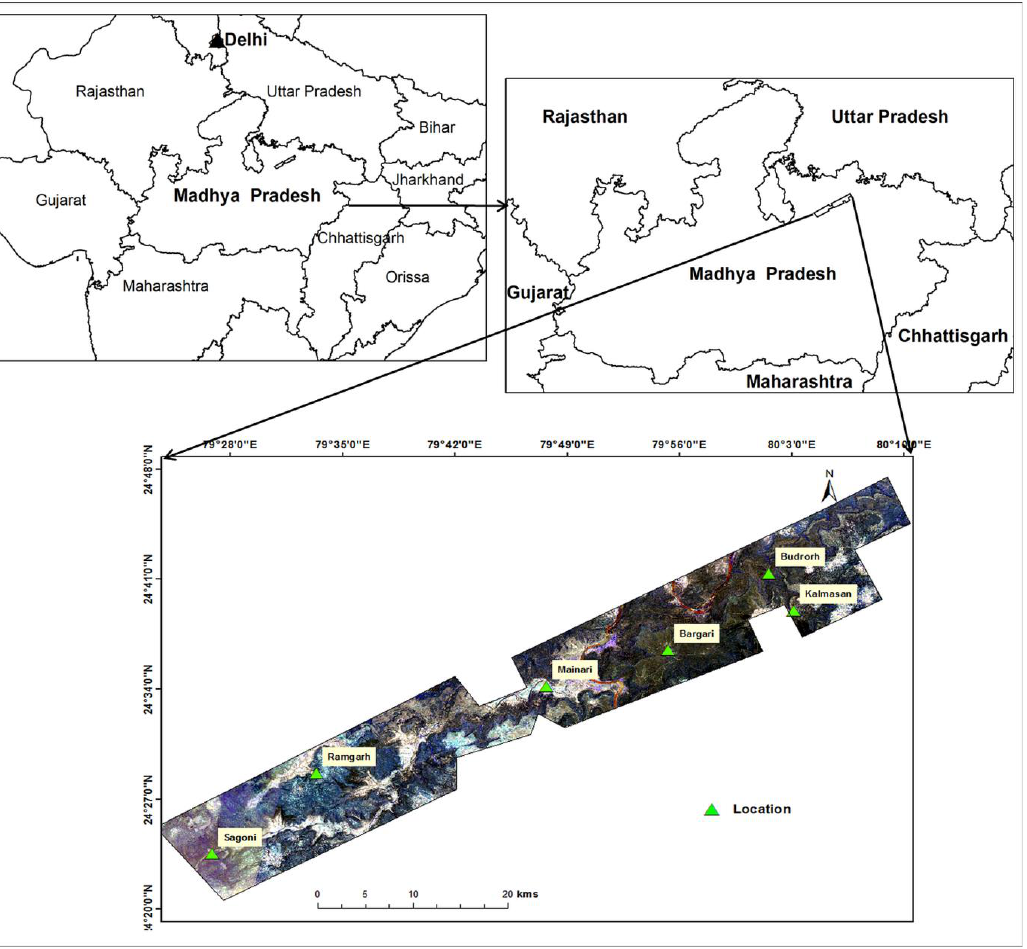
Figure 1. Study area map showing political outline of the state Madhya Pradesh in the which the present study site is located. LISS-IV colour composite image with Red-Green-Blue display is shown( In the FCC image, Red=band 4, Green= band 3 and Blue= band